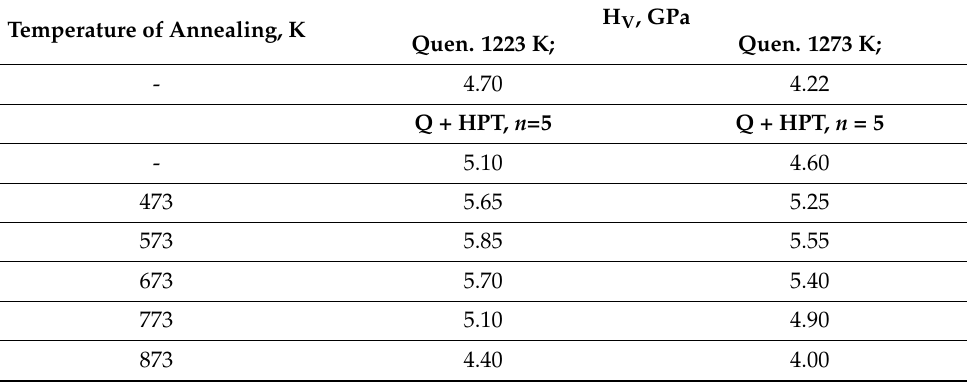
Table 4. Dependence of the microhardness of the Cu–14Al–3Ni alloy on the temperature of annealing for 30 min after quenching and HPT of n = 5 revs.